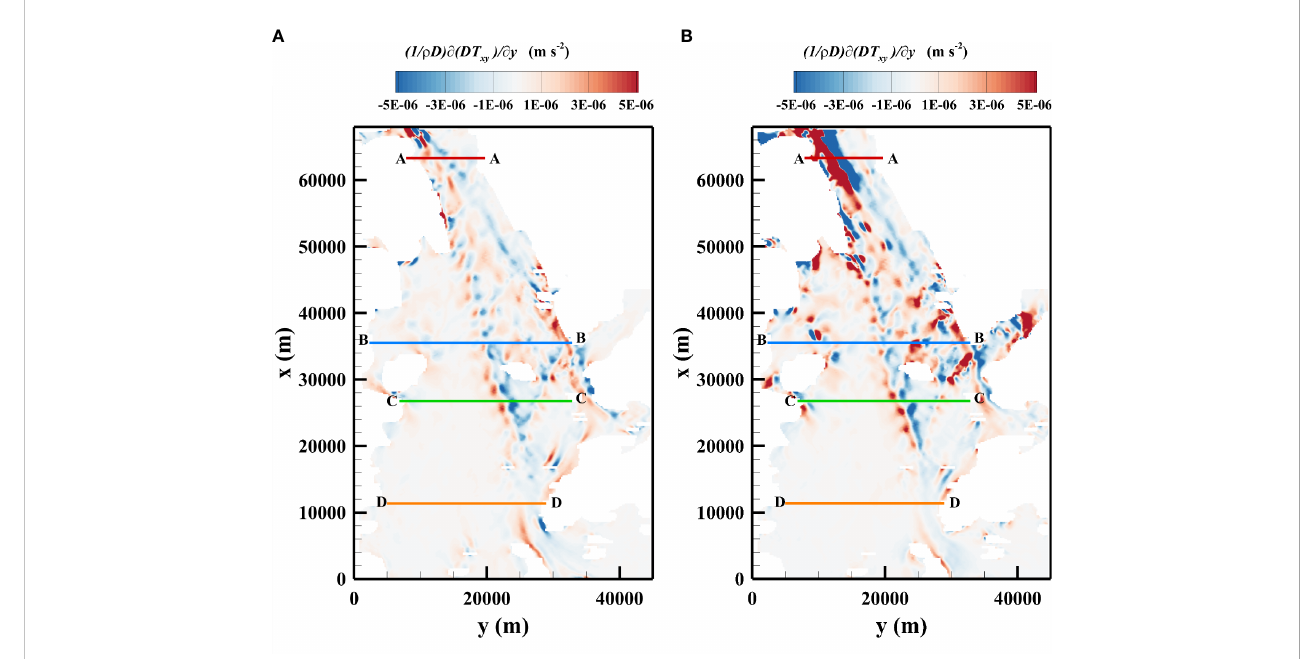
FIGURE 8 (A) Map of the transverse shear stress 1 = ( r D )( ∂ D (cid:1)T xy ) = ( ∂ y ) taken during peak fl ood. (B) Map of the transverse shear stress 1 = ( r D )( ∂ D (cid:1)T xy ) = ( ∂ y ) taken during peak